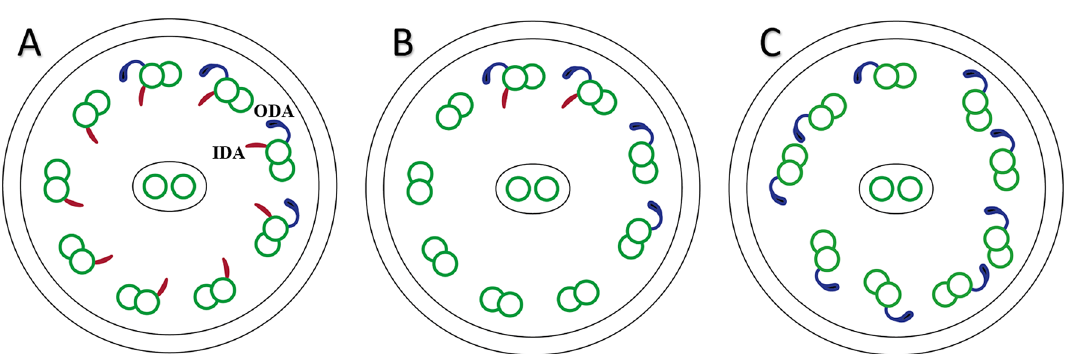
Figure 2. Class 1 (hallmark) defects. ( A ) Outer dynein arm (ODA) defect: the absence of at least 7 out of 9 arms like this schematic cross-section in more than 50% of cilia. ( B ) ODA defect with inner dynein arm (IDA) defect which is defined as the absence of at least 5 out of 9 arms like here in more than 50% of cilia. ( C ) Microtubular disorganization (MTD) and IDA defect: the presence of IDA defect with disruption of 9 + 2 symmetry in more than 25% of